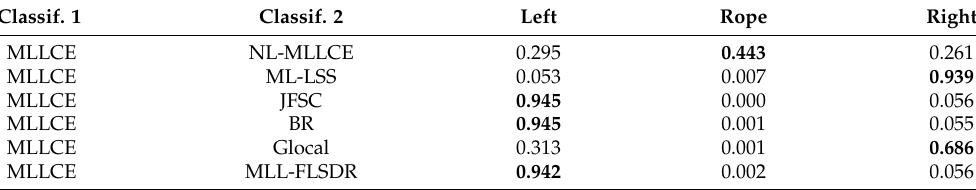
Table 12. Probabilities for the six comparisons of classifiers in terms of Example-based F1. Left and right refer to the columns Classif. 1 ( left ) and Classif. 2 ( right